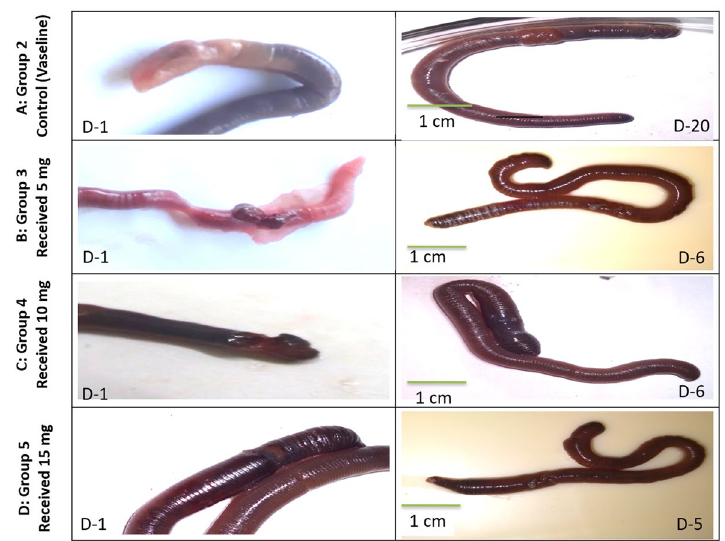
Figure 4. Macroscopic observation of the different groups of earthworms ( Lumbricus castaneus ) after induction of surgical wounds and examination of wound healing; ( a ) worms received Vaseline; ( b ) worms received 5 mg; ( c ) worms received 10 mg, and ( d ) worms received 15 mg.